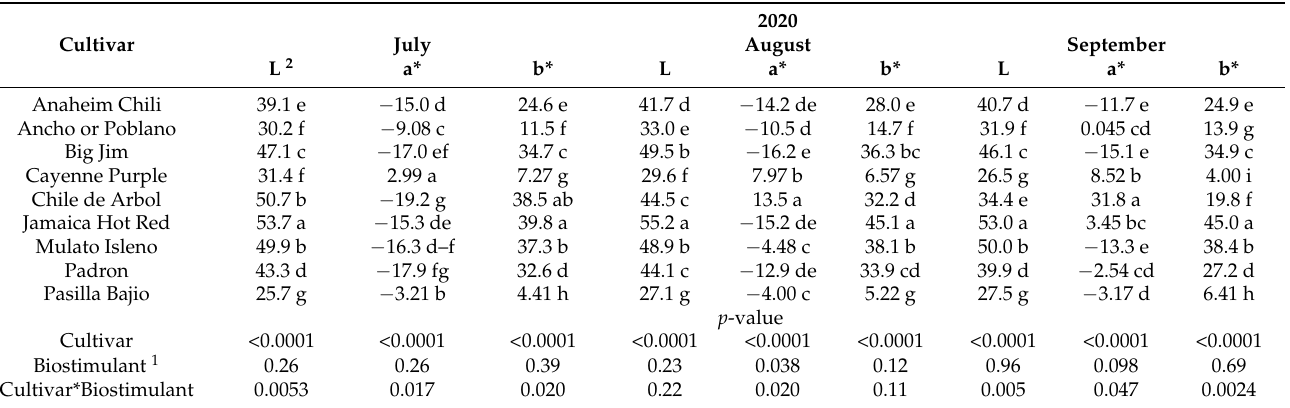
Table 8. Fruit color measurements of nine heirloom chile pepper cultivars treated with three types of biostimulants grown in a container production system in Starkville, Mississippi, in 2020.